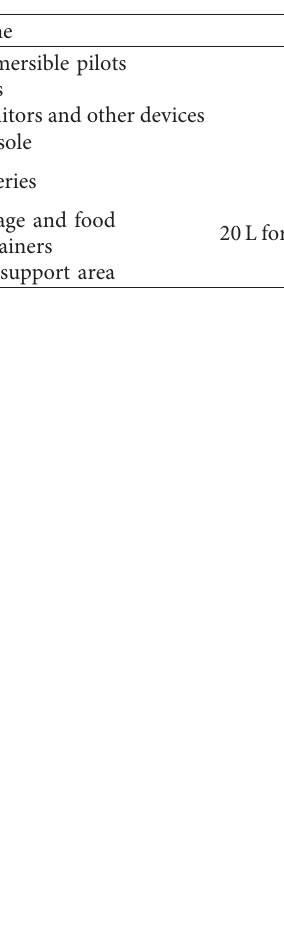
Figure 1: Symbolic expression in the spherical cabin.